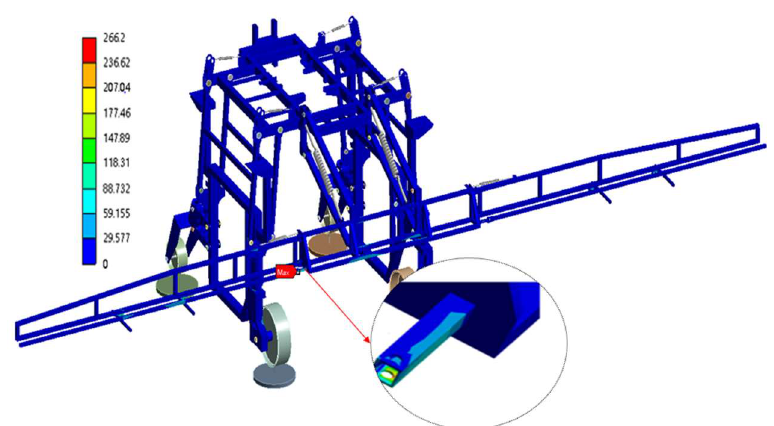
Figure 11. Von Mises stresses the distribution diagram of the 0.93 s